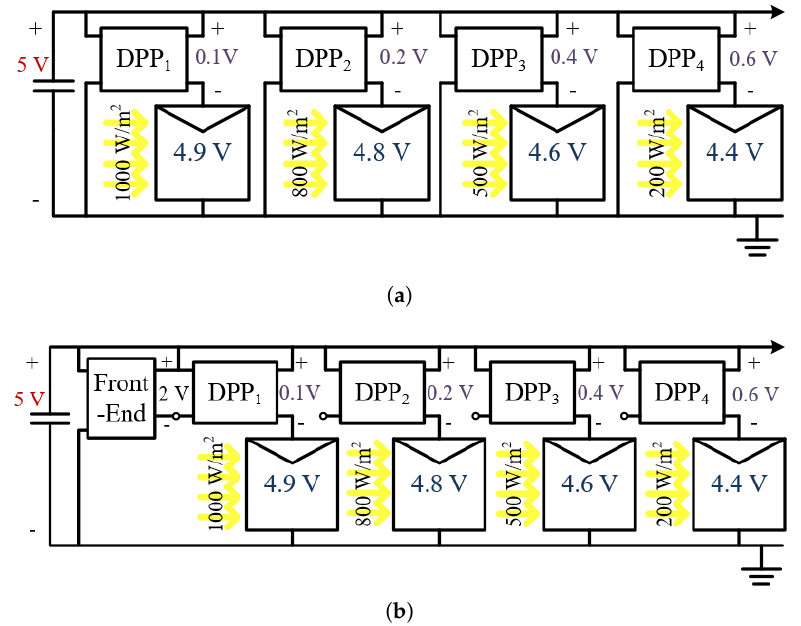
Figure 4. Example irradiance conditions and voltages ( a ) without and ( b ) with a front-end